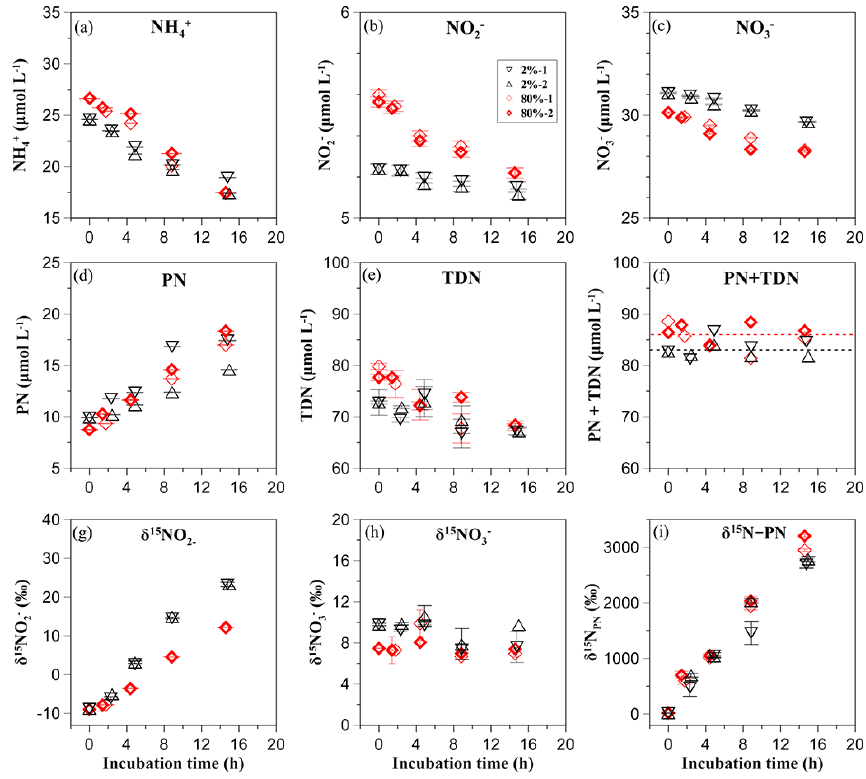
Figure 3. The observational data in the high-nutrient case for (a) [NH + (g) δ 15 N-NO − , (h) δ 15 N-NO − , and (i) δ 15 N-PN. The light and dark red diamonds represent the paralleled samples in 80% sPAR case and 2 3 the black regular and inverse open triangles represent the paralleled samples in 2% sPAR case. Bars represent analytical